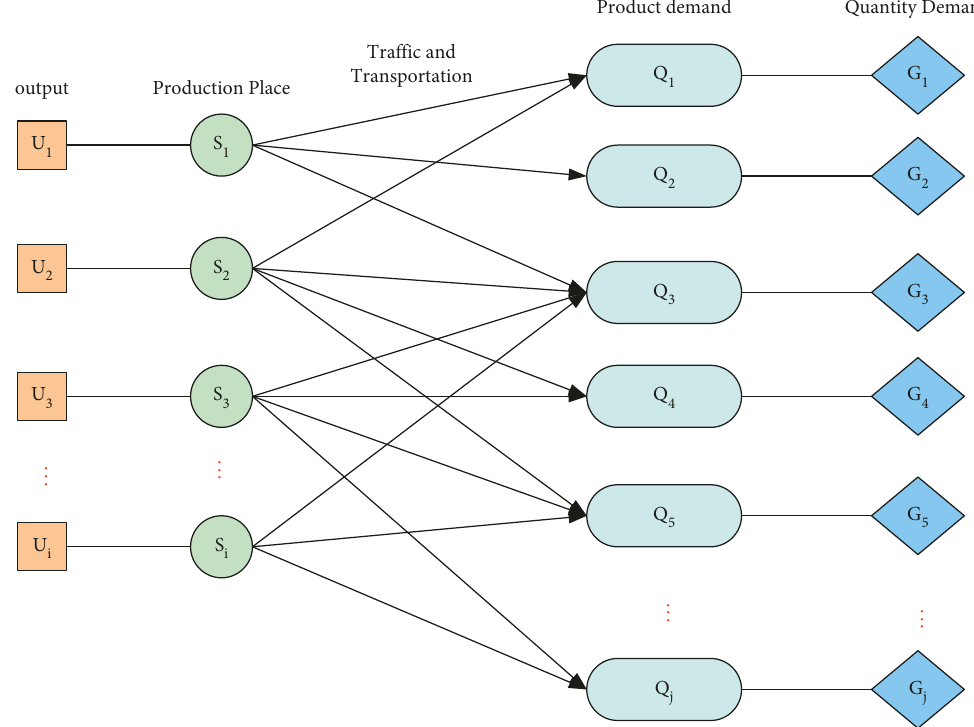
Figure 5: Schematic diagram of the transportation